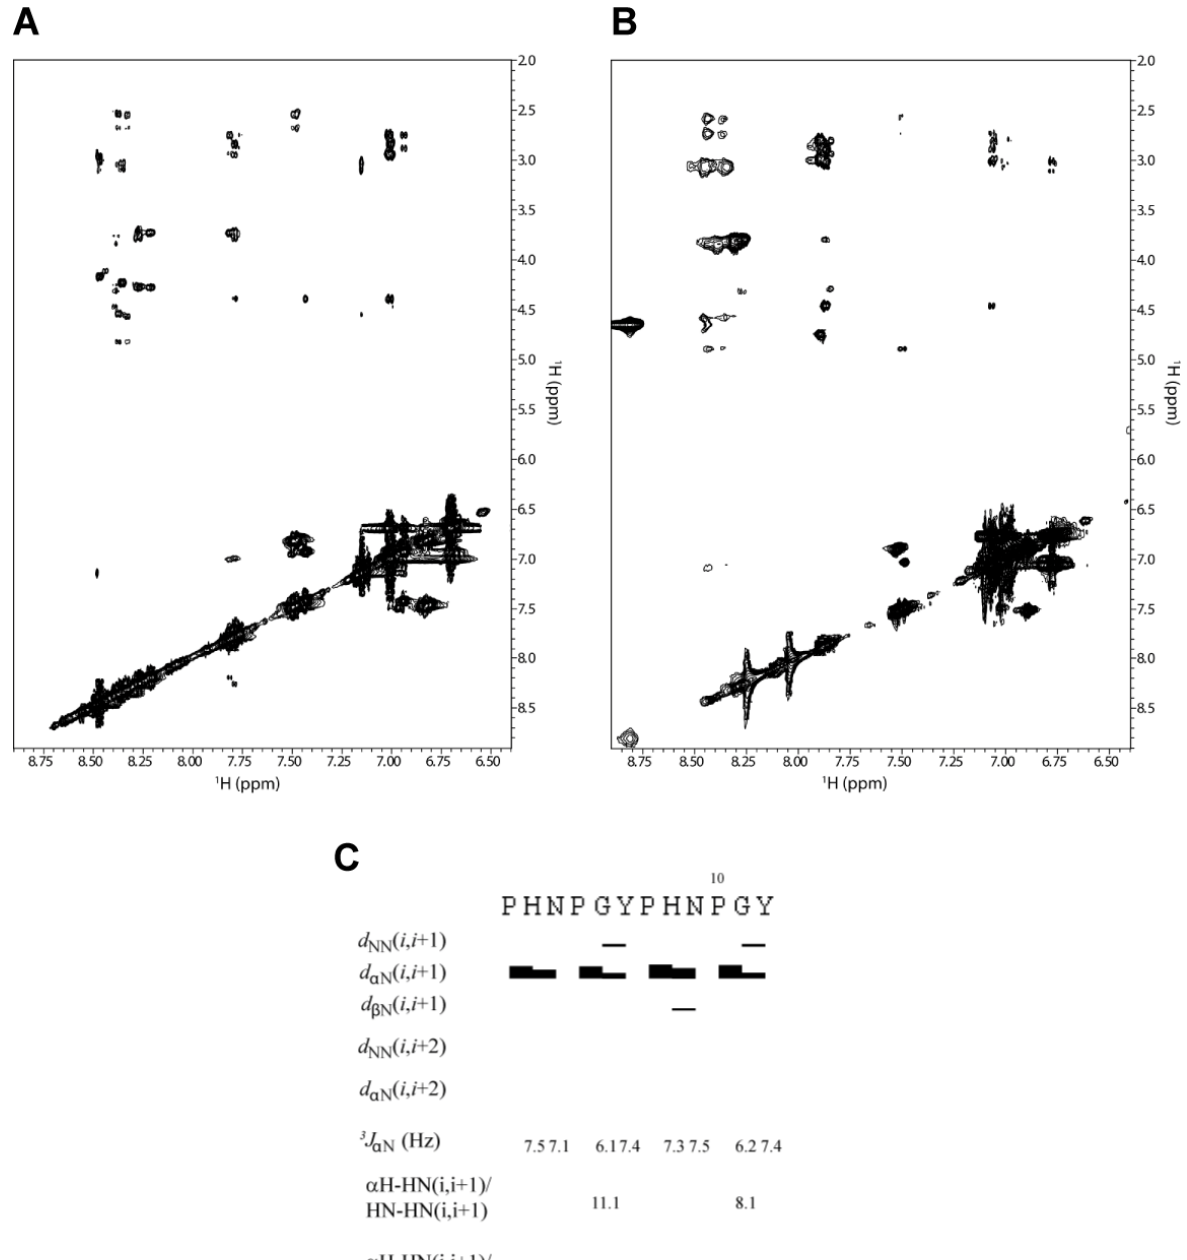
Figure 3. The amide proton region of the 2D 1 H- 1 H ROESY spectrum of 2-HexaPY acquired in water ( A ) and urea ( B ), respectively. ( C ) Summary of NMR parameters of 2-HexaPY. The summary includes the NOEs diagram, 3 J HNH α coupling constants at 300 K and temperature coefficients. The intensity ratios of α H–HN(i,i+1)/HN-HN(i,i+1) and α H–H N(i,i+1)/ α H–HN(i,i) are also